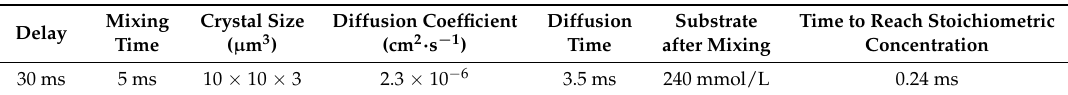
Table 1. Time scales and other parameters important for consideration in a mix-and-inject experiment aimed to investigate an enzymatic reaction at a time delay of 30 ms after